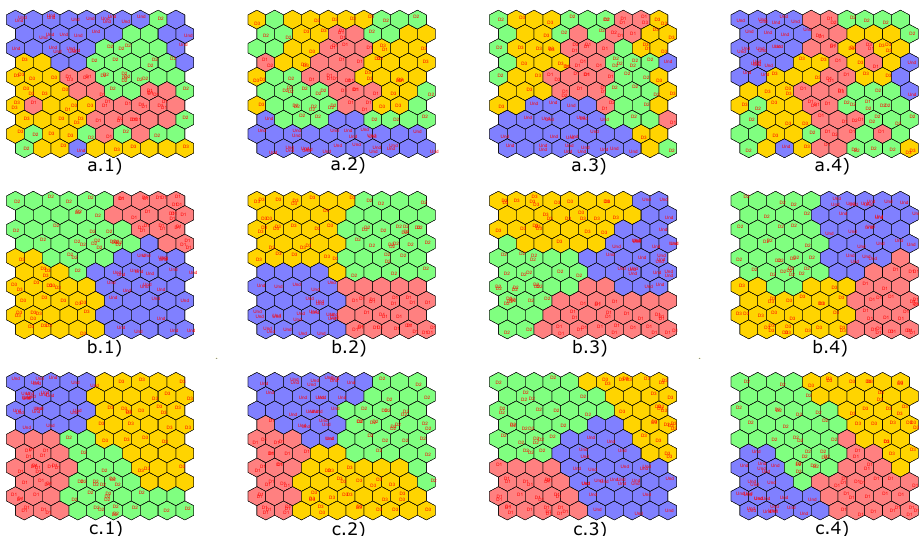
Figure 28. Results obtained by implementing the CPANN ( a ), SKN ( b ) and XYF ( c ) networks for: 2principal components (group 1), 4 principal components (group 2), 6 principal components (group 3) and 8 principal components (group 4).